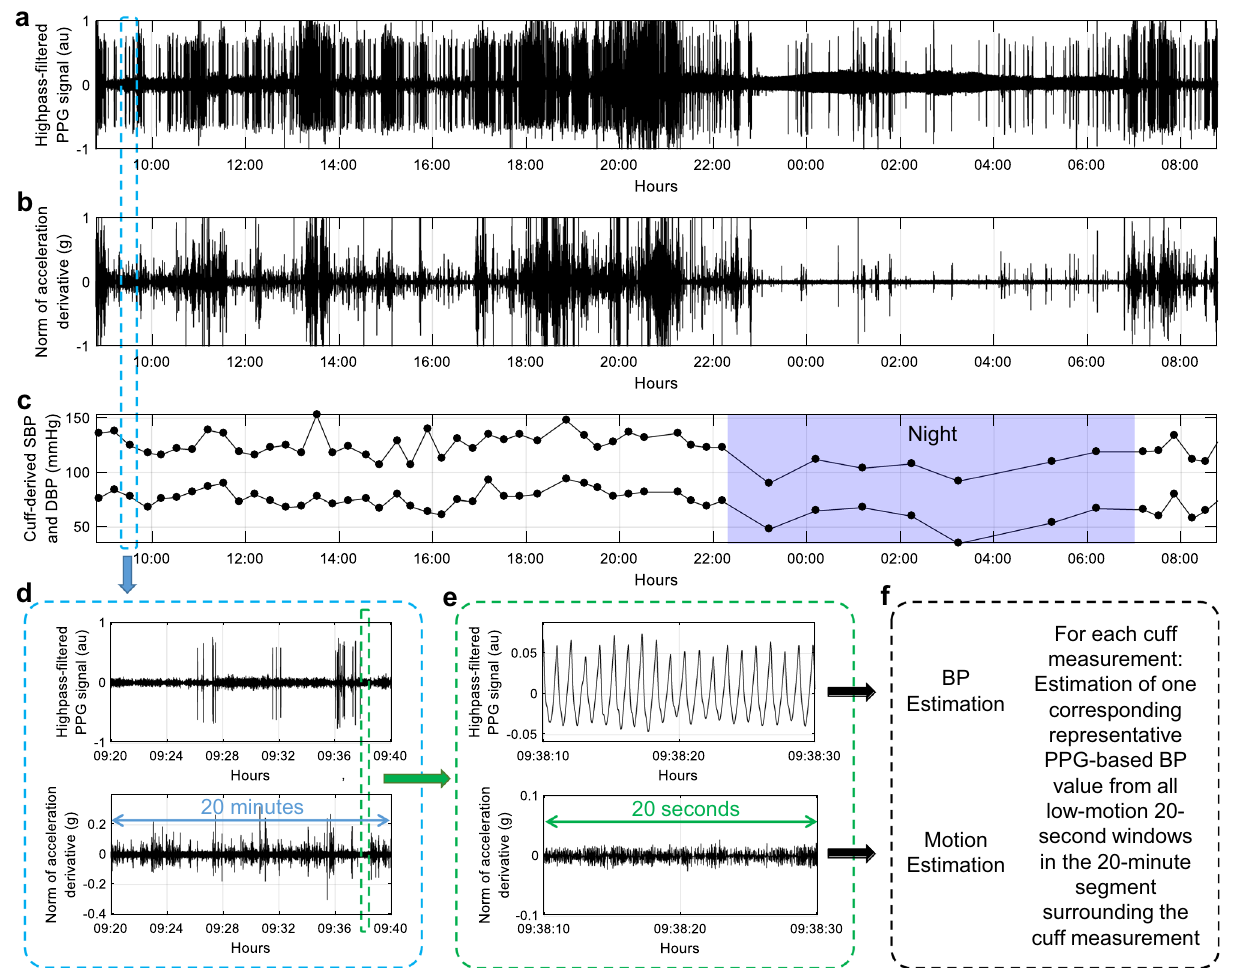
Figure 3. Illustration of the PPG data processing approach, from signal segmentation to BP estimation. ( a ) Example of a 24-h baseline-corrected (highpass-filtered) PPG signal measured by the PulseWatch. ( b ) The corresponding 24-h first derivative of the acceleration Euclidian norm used for assessing the amount of motion. ( c ) The 24-h cuff-based BP profile of the patient. ( d ) 20-min segment surrounding a cuff measurement. ( e ) 20-s window used to obtain one BP estimate and one motion estimate. ( f ) From the BP estimates of all low- motion 20-s windows in the 20-min segment, one representative PPG-based BP value is estimated. PPG photoplethysmography, BP blood pressure, au arbitrary